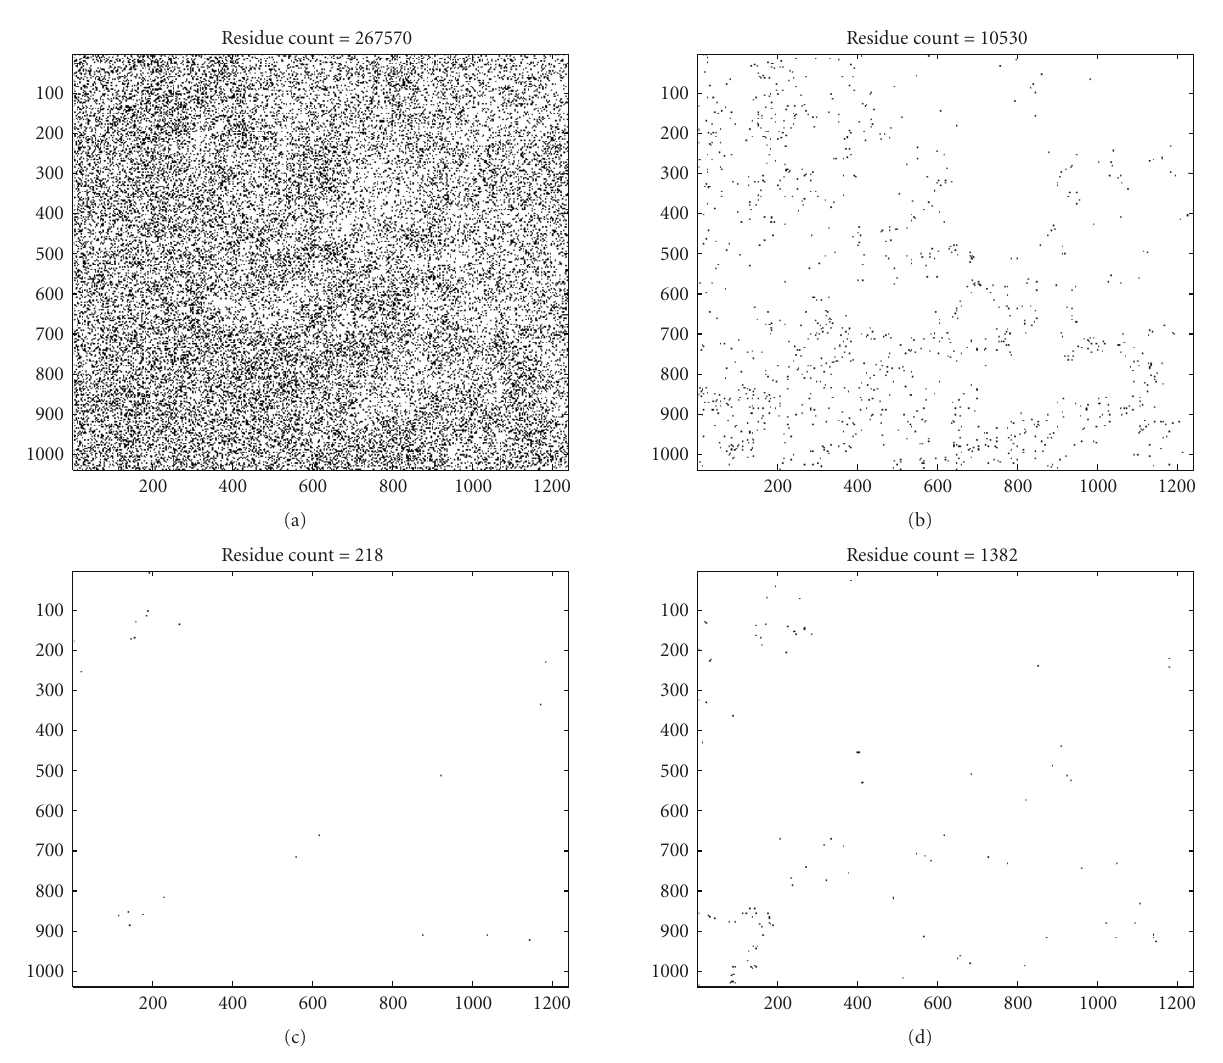
Figure 7: Residues of the interferograms: (a) original, (b) reference (median filtered), (c) output of proposed filter, (d) 11 × 11 boxcar